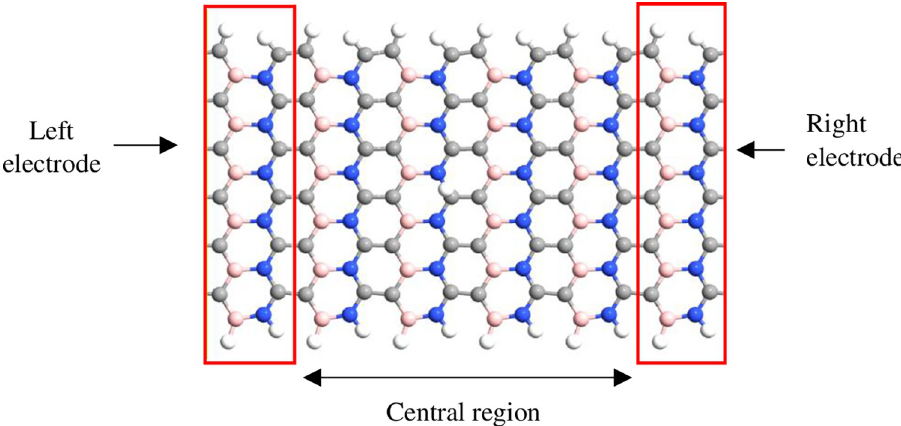
Fig 13. BC 2 N-based sensor connected with two electrodes for detecting H 2 gas molecules at the position of carbon.